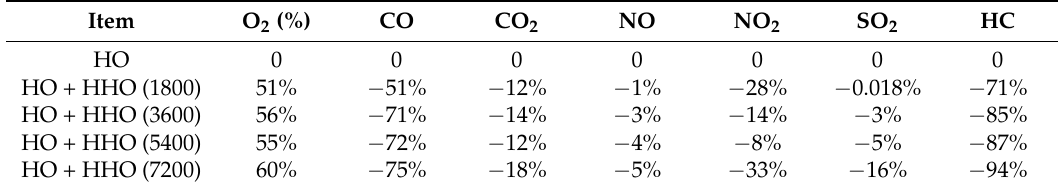
Table 12. The reduction amounts (%) of various particles when combining HO with various amounts of HHO.